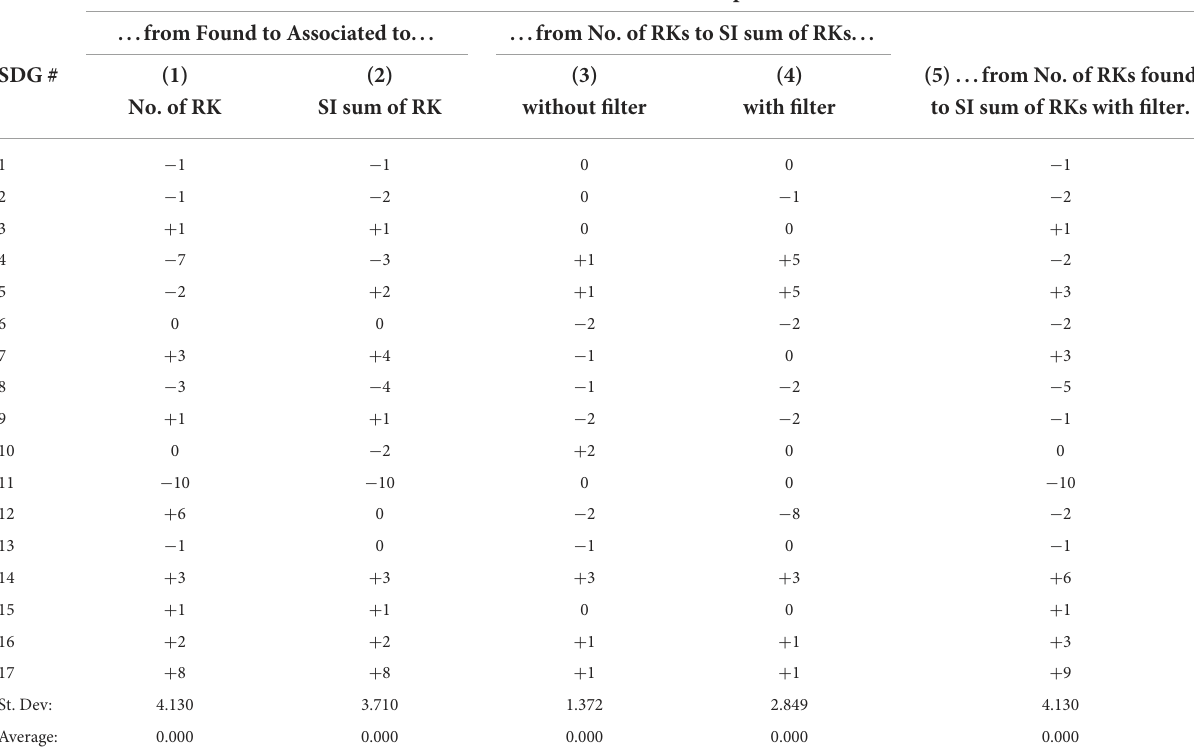
TABLE 2 Variation of the SDG position based on the number of RK detected and their sustainable importance with and without the filter criteria. Variation of the SDG ordered position... ...from Found to Associated to... ...from No. of RKs to SI sum of RKs... (5) ...from No. of RKs found with filter to SI sum of RKs with